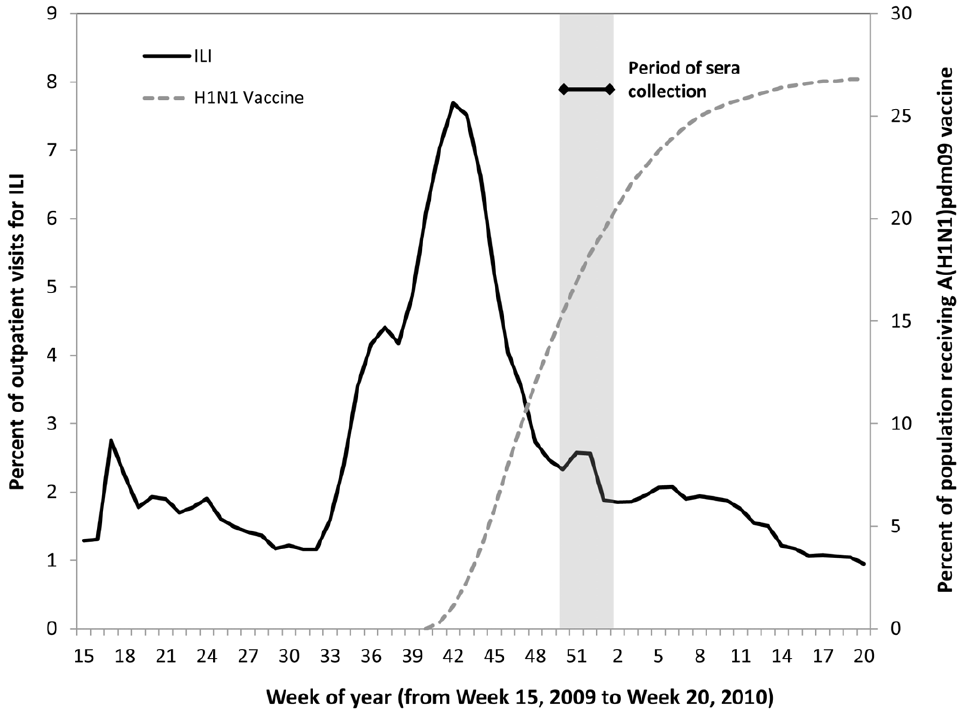
Figure 1. National trends in influenza–like illness (ILI) (solid line) a and coverage with A(H1N1)pdm09 vaccine (dashed line) b in the United States, and the period of sera collection. a Source: U.S. Outpatient Influenza-like Illness Surveillance Network (ILINet). b Source: CDC estimates from combined Behavioral Risk Factors Surveillance System (BRFSS) and National 2009 H1N1 Flu Survey (NHFS) data.